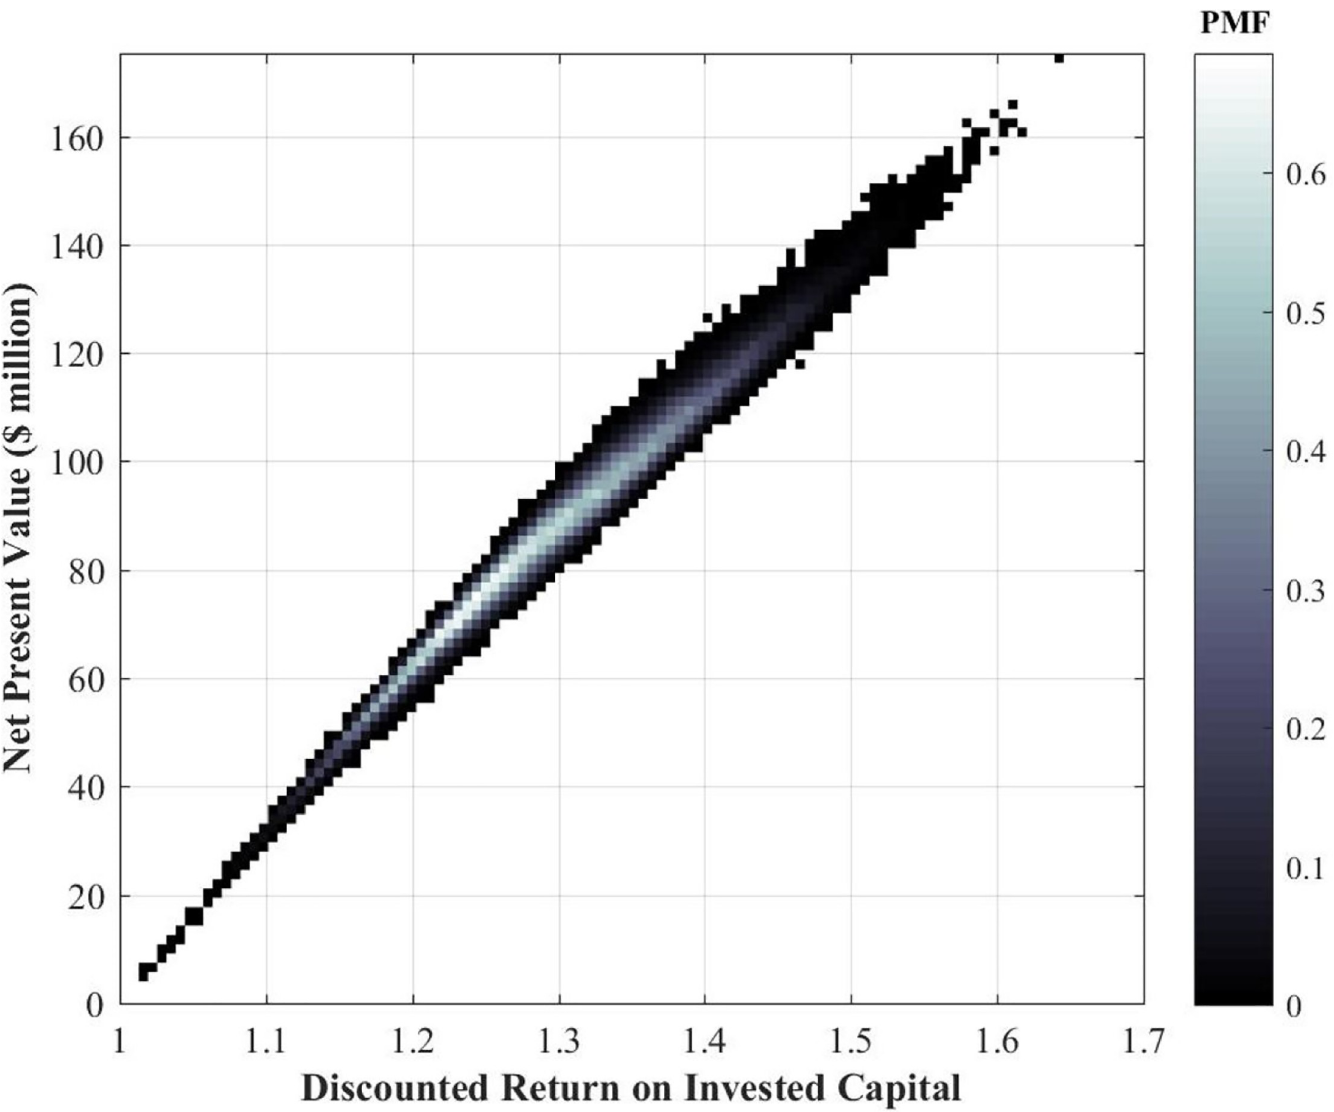
Fig 4. Joint distribution of traditional wide-beam satellite NPV and d-ROIC for the same 60-equivalent-transponder wide-beam communication satellite after a design life of 15 years on-orbit.